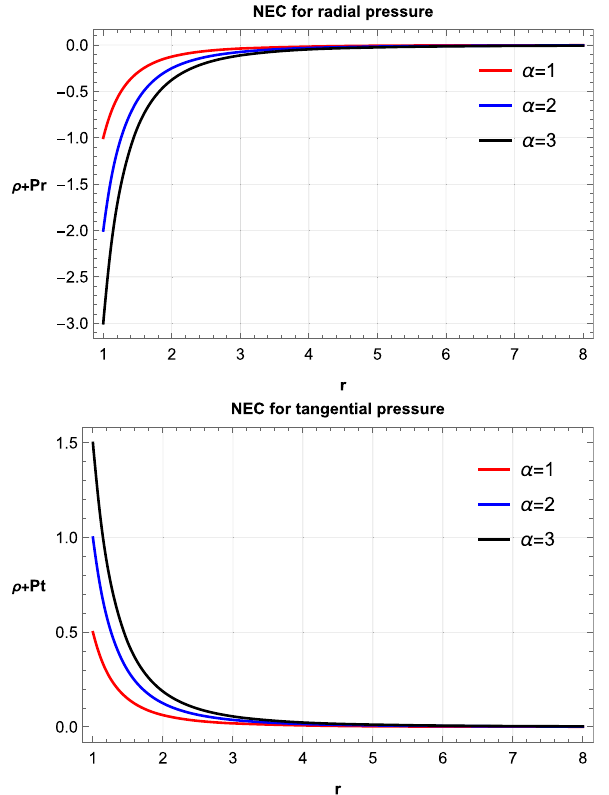
Fig. 12 The variation of DEC against r for two sphere (case-1) with r 0 = 1 and A = 0 .